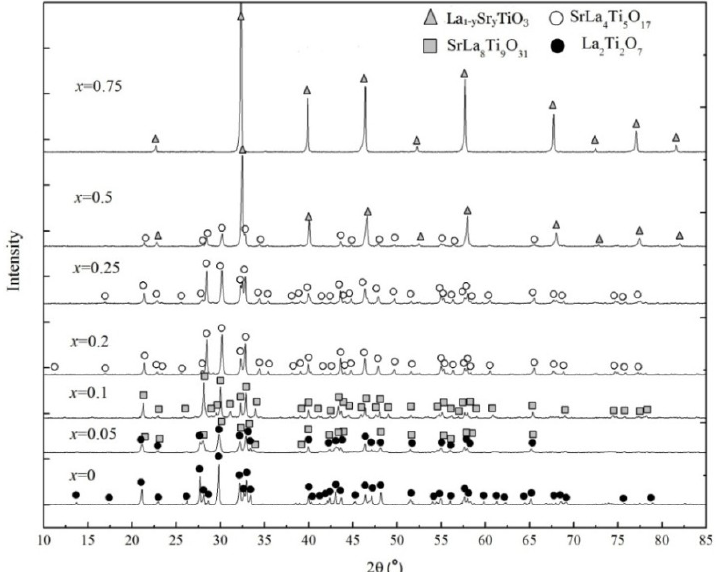
Sr TiO as functions of x (0 ≤ x 1− x x 3+δ